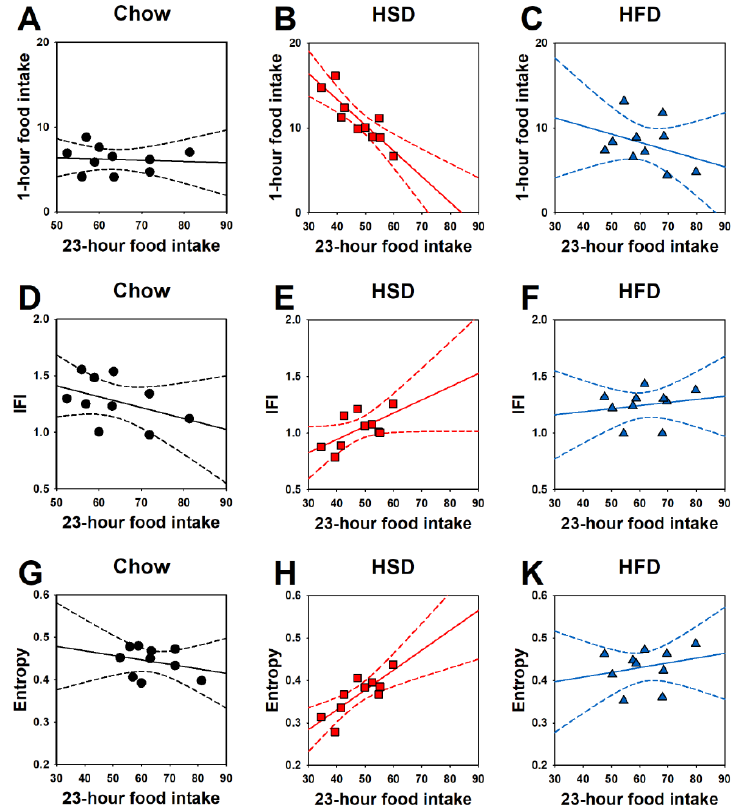
Figure 4. Effects of daily 1-h operant self-administration of Chow, HSD, or HFD on correlations between 23-h home-cage food intake and ( A , B , and C ) 1-h food intake, ( D , E , and F ) inter food interval (IFI), or ( G , H , and K ) entropy in female Sprague Dawley rats ( n = 10/group). For such analyses, the averages of days 13–21 were used, a period in which HSD 23-h food intake started being significantly lower than controls. Rats were given the chance to self-administer one of the three diets in a fixed ratio 1 schedule during a 21-day period. Chow was otherwise freely available in the home cages.